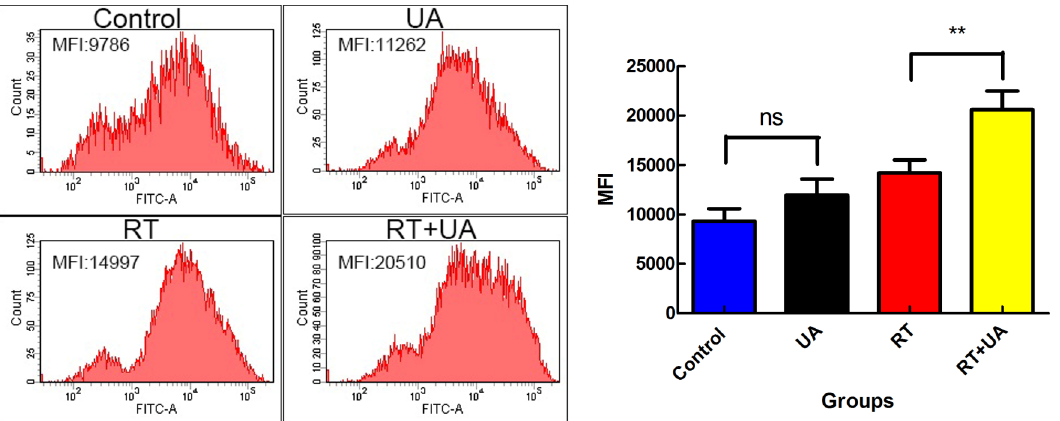
Fig 4. Effects of UA and radiation on ROS formation. The concentrations of intracellular ROS were detected using the membrane-permeable fluorescent probes 20, 70-dichlorofluorescin diacetate (DCFH-DA) by flow cytometry. The mean fluorescent intensity (MFI) represented intracellular ROS level. The MFIs difference between combination group and RT group was significant (P < 0.01) (ns: not significant; ** :P < 0.01).